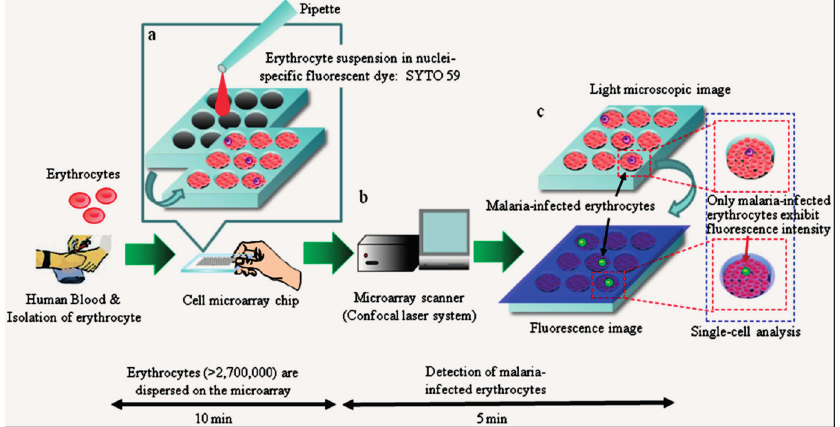
Figure 8. Schematic diagram of the process for detection of malaria-infected erythrocytes on a cell microarray chip. ( a ) Erythrocytes stained with a nuclei-specific fluorescent dye, SYTO 59, for the staining of malaria nuclei dispersed on a cell microarray chip using a pipette, which led to the formation of a monolayer of erythrocytes in the microchambers; ( b ) Malaria-infected erythrocytes were detected using a microarray scanner with a confocal fluorescence laser by monitoring fluorescence-positive erythrocytes; ( c ) The target malaria-infected erythrocytes were analyzed quantitatively at the single-cell level. Reproduced with permission [97]—open